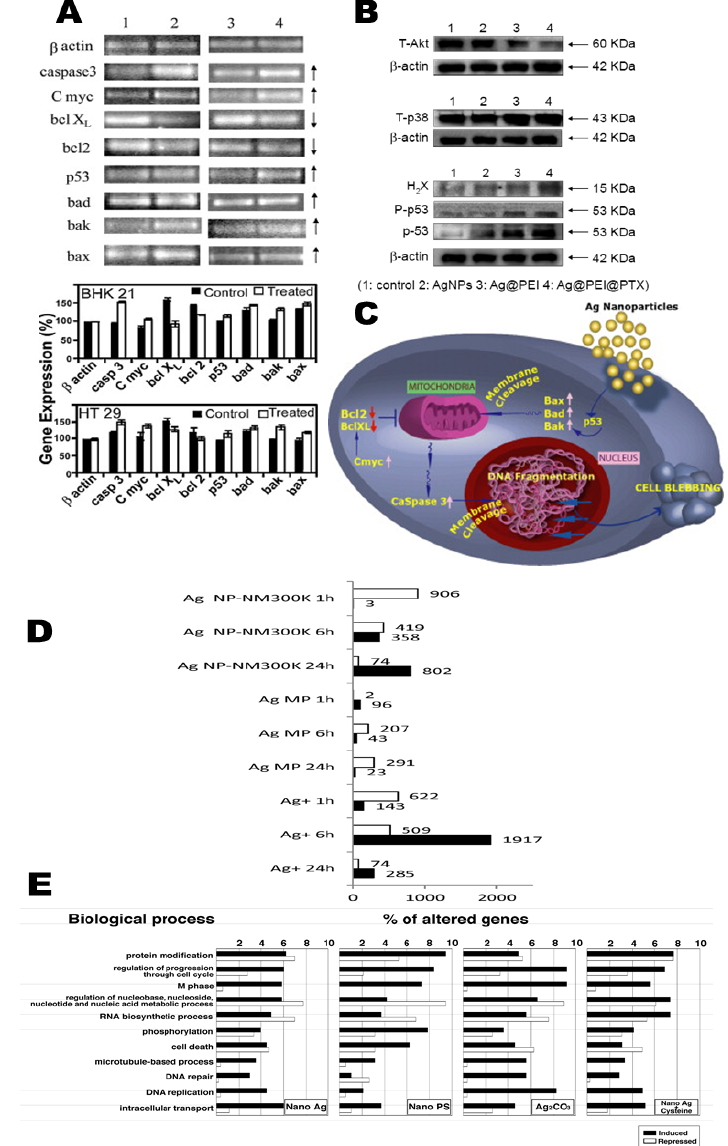
Figure 6. AgNPs inhibit the various proteins expression associated with NF-kB-based apoptosis. (A) Immunoblotting analysis of proteins, namely, p-NF-kB, BAD, Bcl-2, and Bax followed by densitometry of immunoreactive bands in 24 h A549 cells. Adapted with permission from Reference [102], Copyright 2010 Elsevier. (B) Microenvironmental apoptotic signaling pathway-related proteins are shown with complex Ag@PEI@PTX exposures in HepG2 cells. Intracellular apoptotic signaling pathway levels of the T-Akt pathway, T-p38 MAPK pathway, and activation of the p53 signaling pathway. β -actin acts as a control. Reprinted with permission from Reference [38], Copyright 2016 Dove Medical Press. (C) Graphic representation of AgNP-induced apoptotic protein expression. Adapted with permission from Reference [102], Copyright 2010 Elsevier. (D) Quantified and significantly altered genes in A549 cells after AgNPs, AgMPs (micro-sized particles), and Ag ions (Ag + ) exposures delivered from various time scales. Adapted with permission from Reference [114], Copyright 2018 Royal Society of Chemistry. ( E ) 521, 188, and 298 genes were significantly modified through pure AgNPs, PS-NPs, and Ag 2 CO 3 exposures, respectively. Every bar explains the ratio of genes categorized in each biological metabolism. Reprinted with permission from Reference [44], Copyright 2009 American Chemical